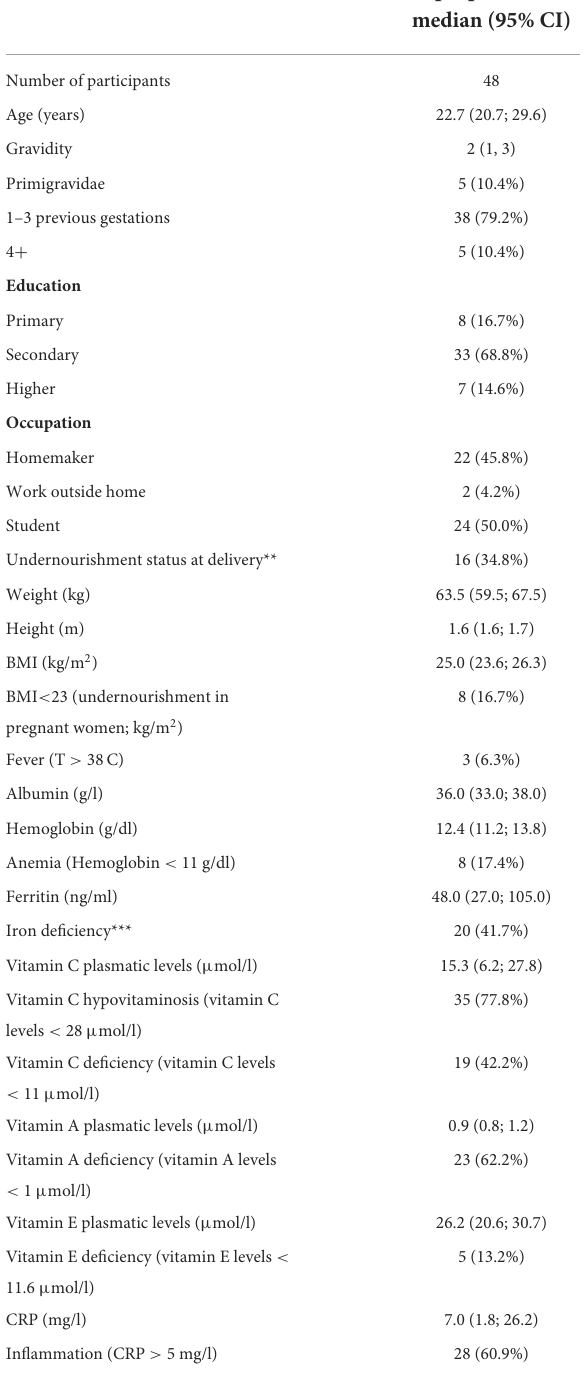
TABLE 1 Baseline characteristics of the women at delivery.